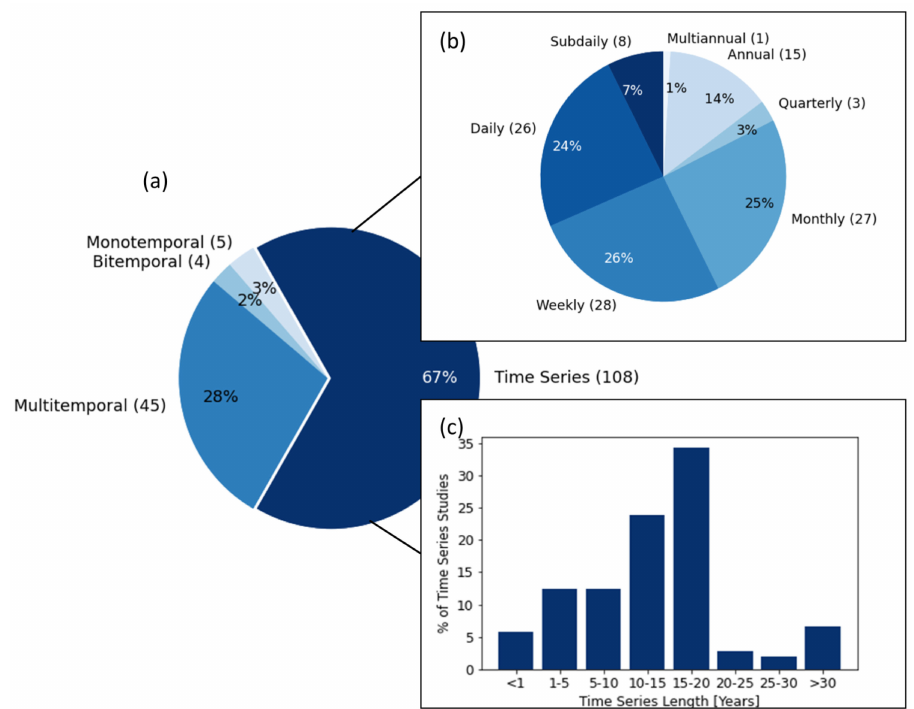
Figure 9. ( a ) Distribution of temporal resolutions of the reviewed studies. The temporal resolutions are classified into Monotemporal, Bitemporal, Multitemporal (3–10 time steps OR >10 time steps with irregular revisit times) and Time Series (>10 time steps AND constant revisit times) ( b ) Distribution of time series frequency of the studies, which are employing a time series ( c ) Distribution of time series length of the studies that employed a time